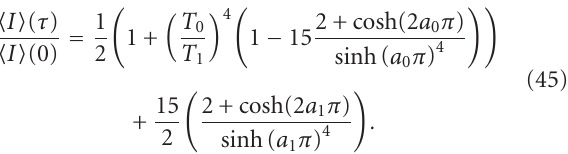
where a 0 = τk B T 0 / (cid:2) and a 1 = τk B T 1 / (cid:2) . The integrals in